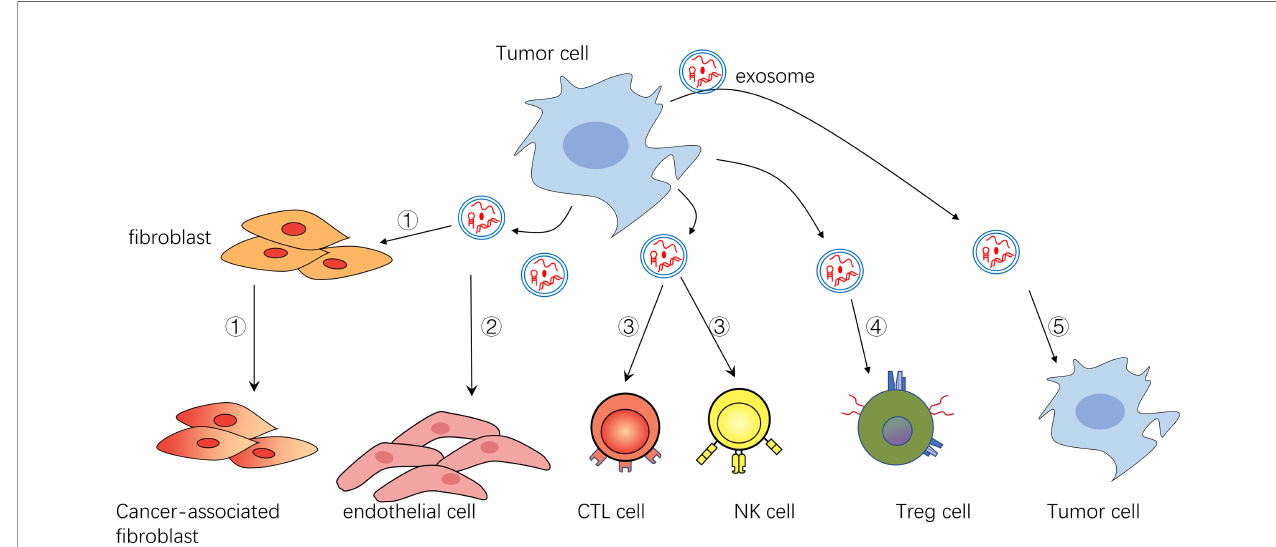
FIGURE 1 | ① Exosomes can transform fi broblasts into tumor-associated fi broblasts ② Exosomes can promote endothelial cell growth and vascular formation ③ Exosomes can inhibit NK cells and CTL cells ④ Exosomes can activate immunomodulatory cells such as Treg cells ⑤ Exosomes can act on themselves or their surrounding tumor cells to promote their survival and inhibit their apoptosis.